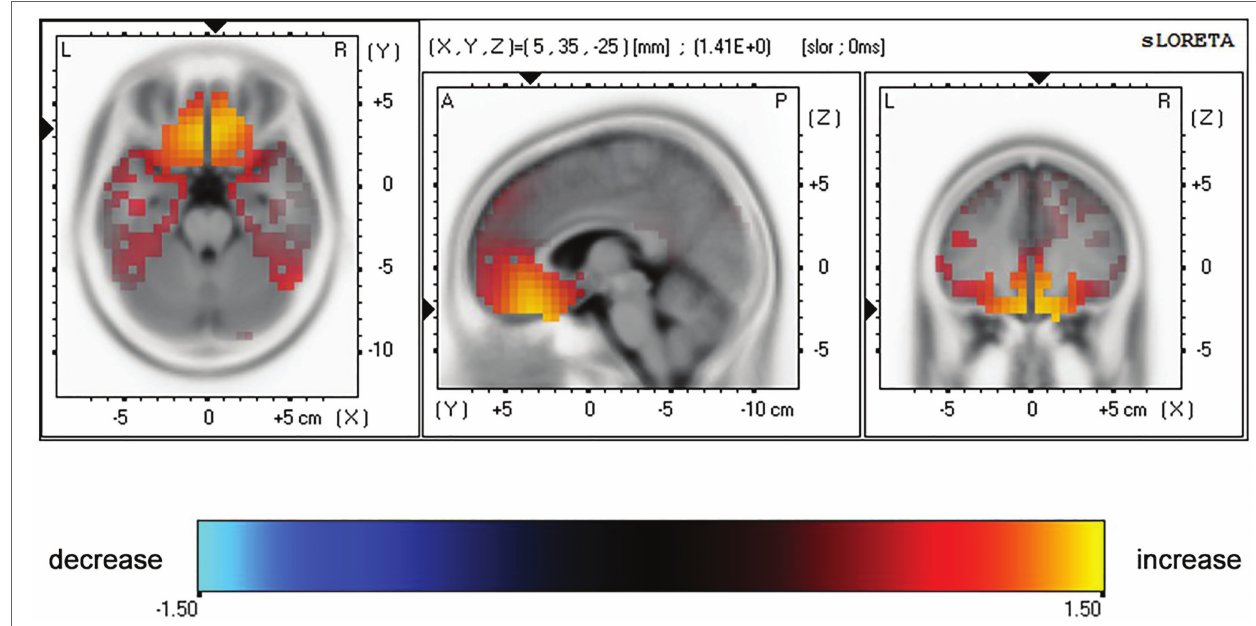
FIGURE 6 | Results of voxel-by-voxel paired t tests contrasting current density for the N170 after presentation of a pair of fearful-neutral facial expressions for older versus younger participants. Yellow: older > young subjects. Statistical maps are presented on the MNI space and thresholded at p < 0.05.